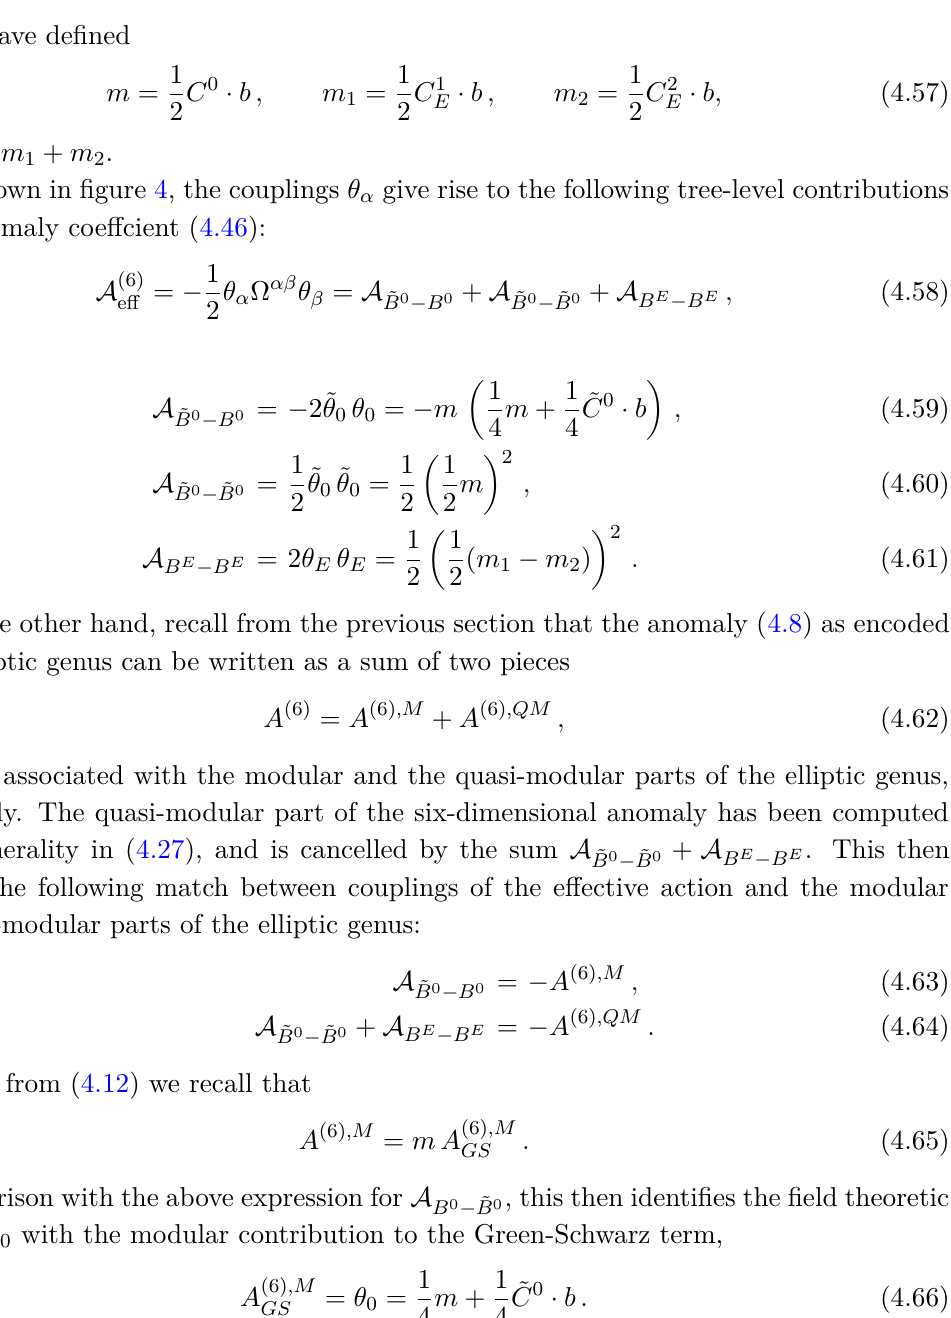
Figure 4 . Contributions to the Green-Schwarz mechanism of a six-dimensional F-theory compact- ification on B 2 = Bl 1 F n . Only the leftmost contribution is perturbative from the perspective of the dual heterotic string, and matches the fully modular contribution from the elliptic